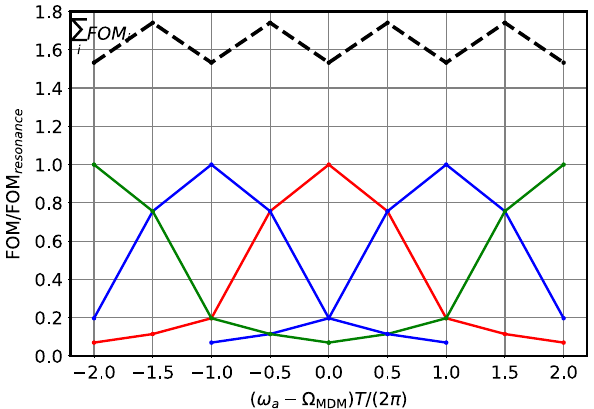
To scan a region of Δ f = 1 kHz with a measurement duration of T = 10 s for a single frequency, one would thus need a total measurement time Δ f T 2 = 10 5 s .